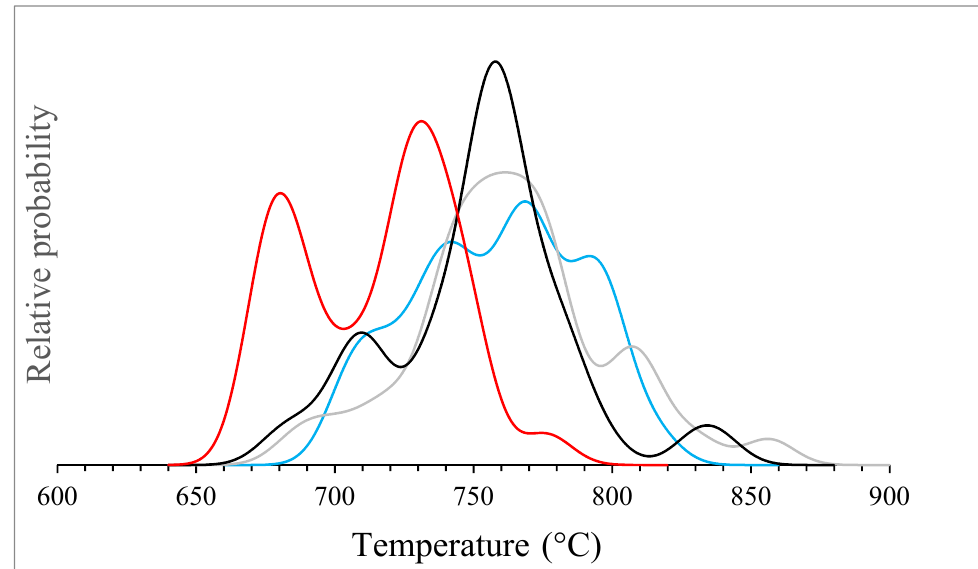
Figure 13. Density curve of zircon crystallization temperatures. Blu line: 2a; grey line: 4c, black line: Likhall; red line: No-ash.